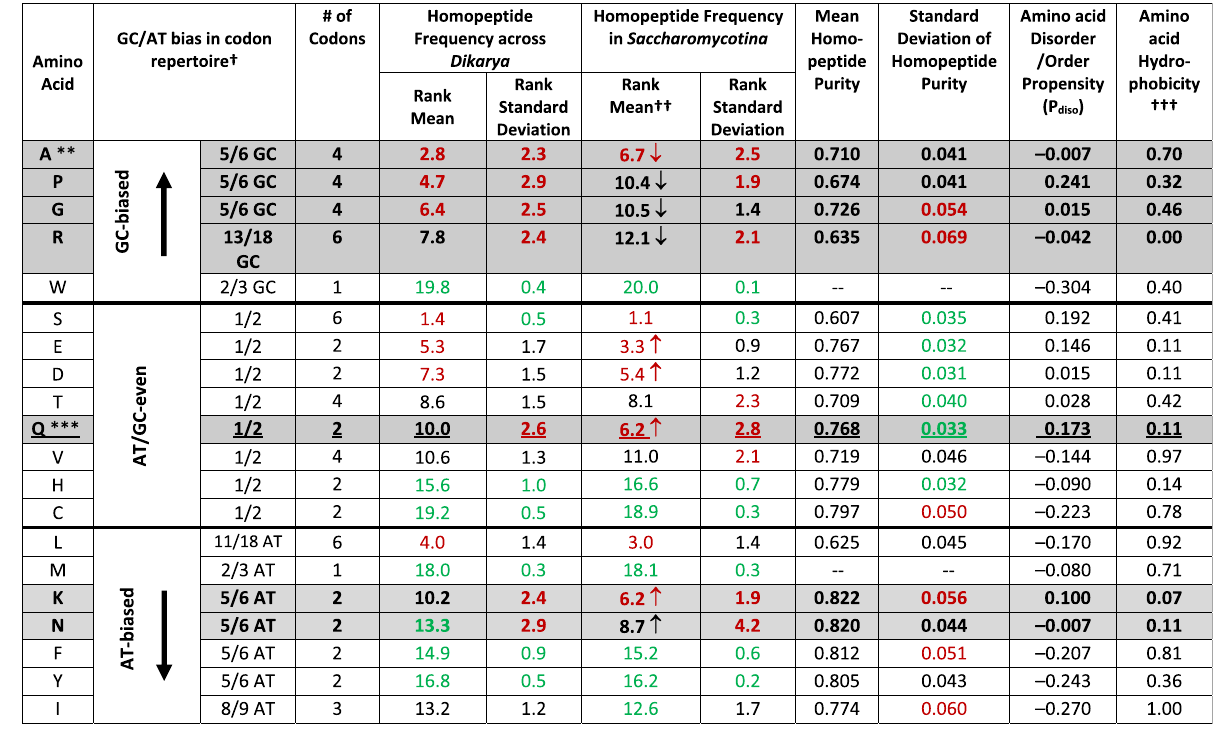
Table 1. Amino-acid homopeptide frequency ranks and purities, disorder propensities and hydrophobicities Amino acids are put in the order from the highest GC bias to the highest AT bias of their encoding codons, and if at the same bias level, they are in the order of the homopeptide frequency rank mean. The frequency rank mean is the mean of the ranking for the amino acid according to its frequency in homopeptides in a proteome; also listed are the rank standard deviations. These are calculated both across the whole Dikarya set and just within Saccharomycotina . **Coloured red are the top thirds of the list of amino acids sorted on: homopeptide frequency rank mean and standard deviation across Dikarya and within Saccharomycotina , and standard deviation of homopeptide purity. Similarly, the bottom thirds of these lists are coloured green. Also, the rows in the table for amino acids with homopeptide frequency rank deviation across Dikarya in the top one third of amino acids are in bold and shaded. *** Q (glutamine) is underlined since among amino acids with an